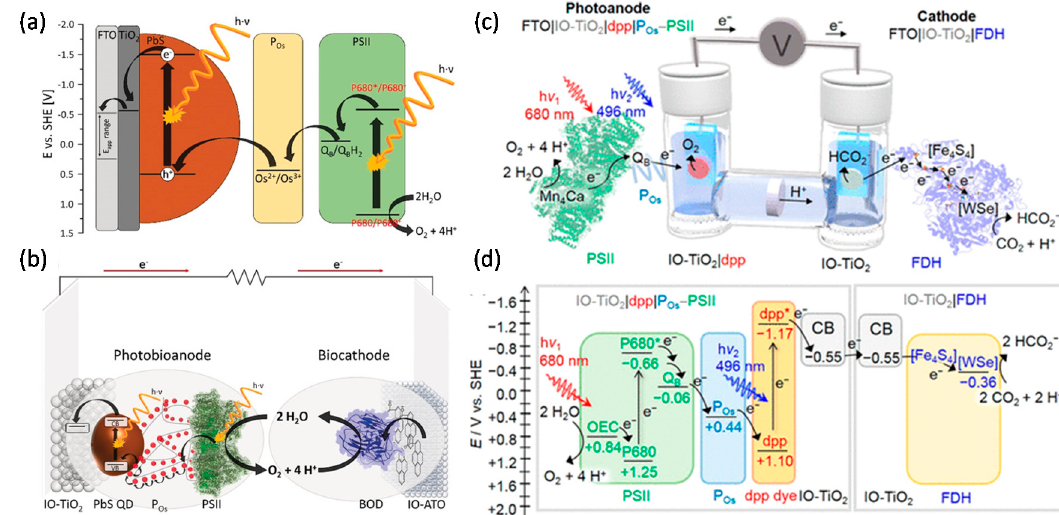
Figure 4. Photoelectrochemical (PEC) cell for electricity or biofuels generation. ( a ) Schematic of the electron transfer steps and energetic level of the components of the light-driven signal chain composed of TiO 2 , PbS QDs, redox polymer (POs), and PSII. ( b ) A scheme of a PEC cell consisting of an IO-TiO 2 |PbS|POs|PSII anode and an IO-ATO|PC|BOD cathode. Reprinted with the permission from ref [181]. Copyright (2019), Wiley. ( c ) A schematic representation of a semi-artificial photosynthetic tandem PEC cell coupling CO 2 reduction to water oxidation. A blend of POs and PSII adsorbed on a dpp-sensitized photoanode (IO-TiO 2 |dpp|POs-PSII) is wired to an IO-TiO 2 |FDH cathode. ( d ) Energy level diagram showing the electron-transfer pathway between PSII, the redox polymer (POs), the dye (dpp), the conduction band (CB) of IO-TiO 2 electrodes, four [Fe4S4] clusters, and the [WSe]-active site in FDH. All potentials are reported vs. SHE at pH 6.5. Reprinted with the permission from ref [184]. Copyright (2018), American Chemical